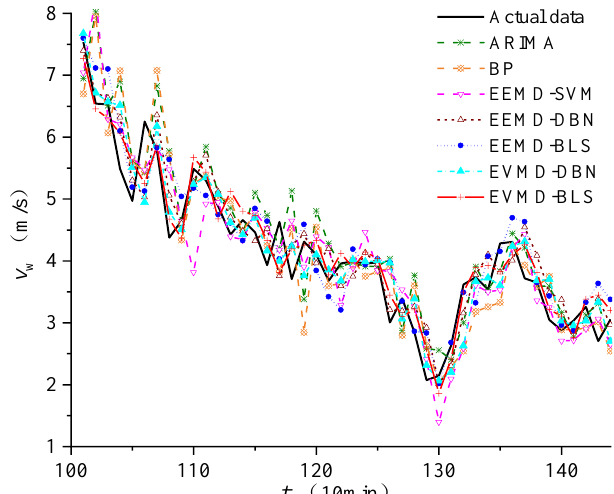
Figure 11. Wind speed forecasting results of seven different models. Table 2. Evaluation result of seven forecasting